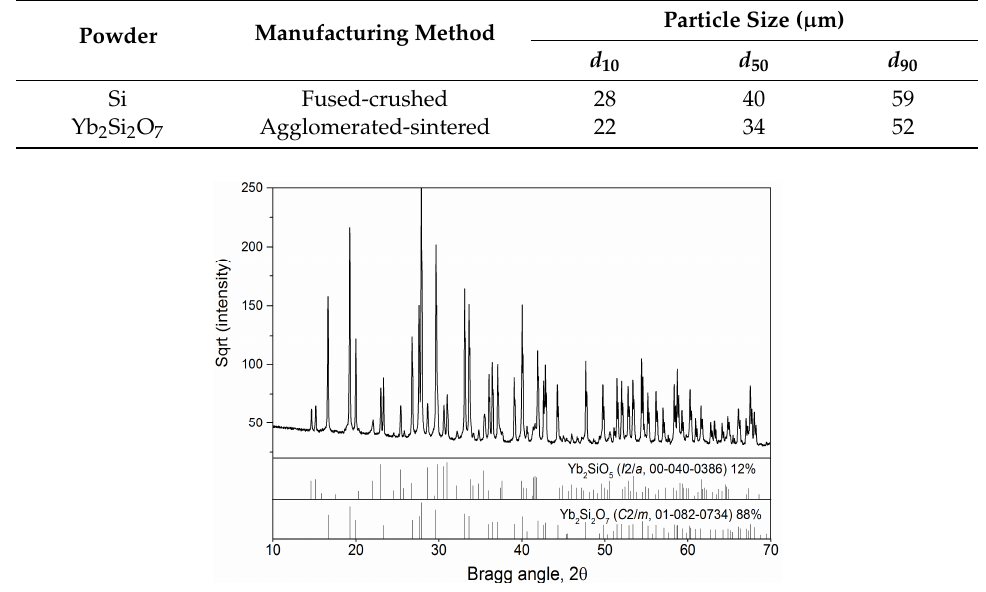
Table 1. Manufacturing method and particle size of the feedstock powders measured with laser